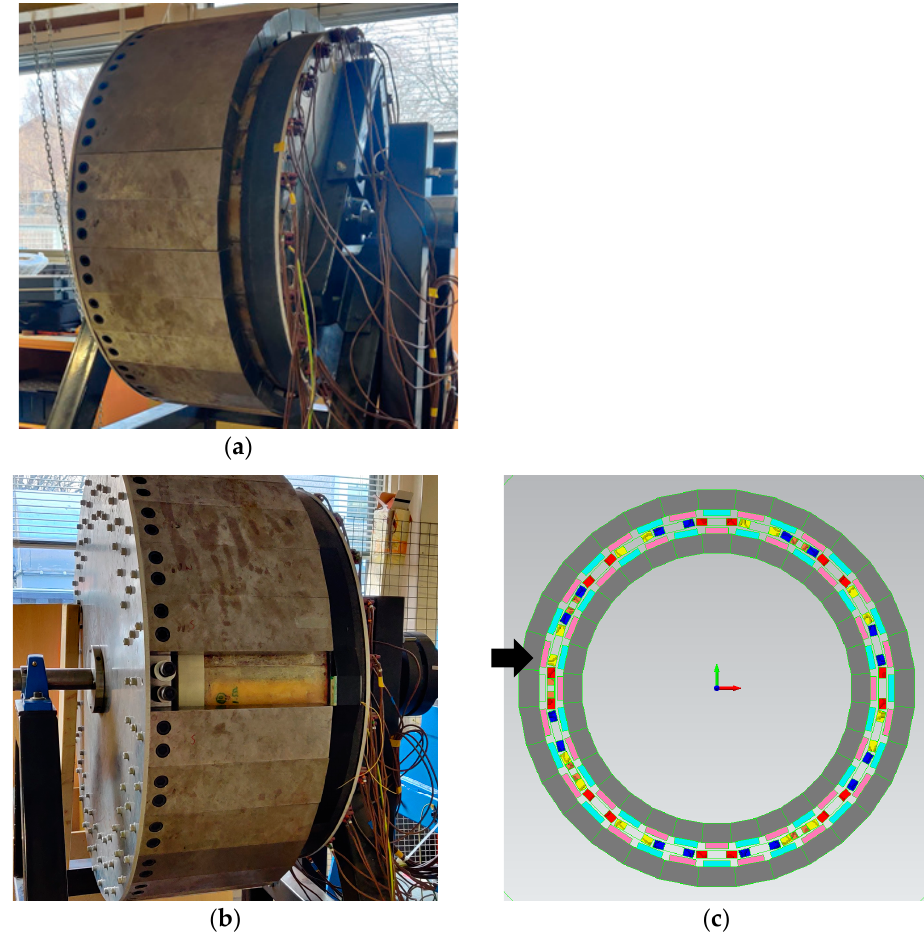
Figure 1. The tested C-Gen PM generator: ( a ) the real generator, ( b ) the generator with one magnet module removed, and ( c ) the FEA model of the machine with an arrow pointing at the faulty mag- net.